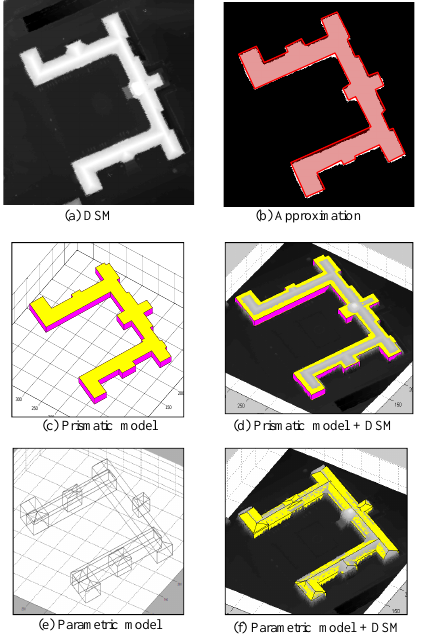
Figure 10: LOD1 and LOD2 as defined in CityGML els extracted from a building block. As shown, the structures of the building shaped by tilted roofs are modeled separately and merged together for final LOD2 generation (cf. Figure 10(e) and 10(f) ) Figure 11 is generated by analyzing the prismatic and para-